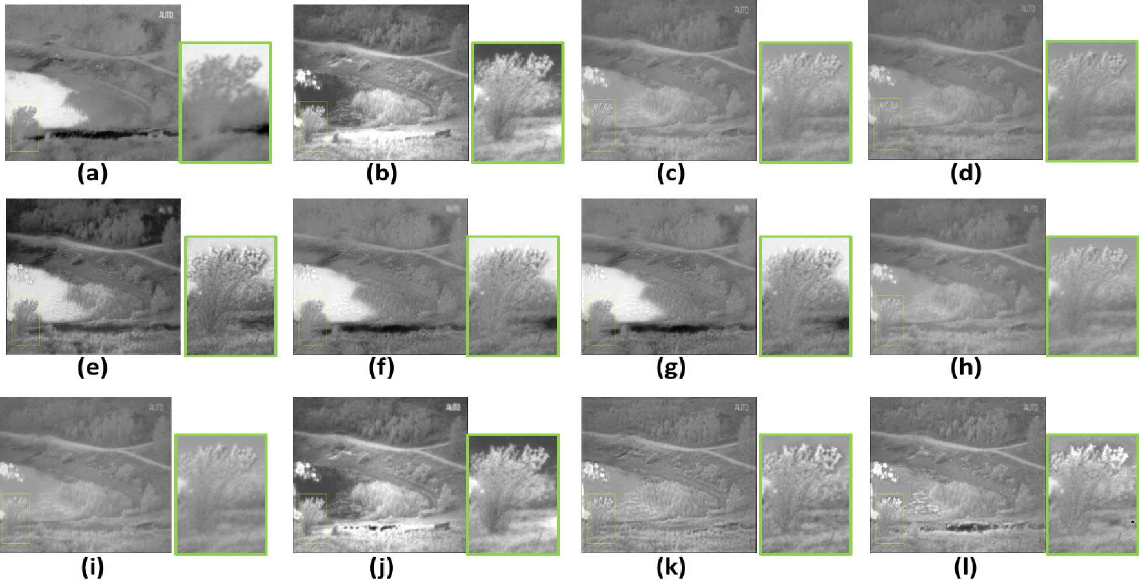
Figure 7. Visual IF results of different methods on lake : ( a ) IR image, ( b ) VIS image, ( c ) Proposed method, ( d ) [17], ( e ) [22], ( f ) [33], ( g ) [20], ( h ) [34], ( i ) [35], ( j ) [36], ( k ) [37], and ( l ) [38].